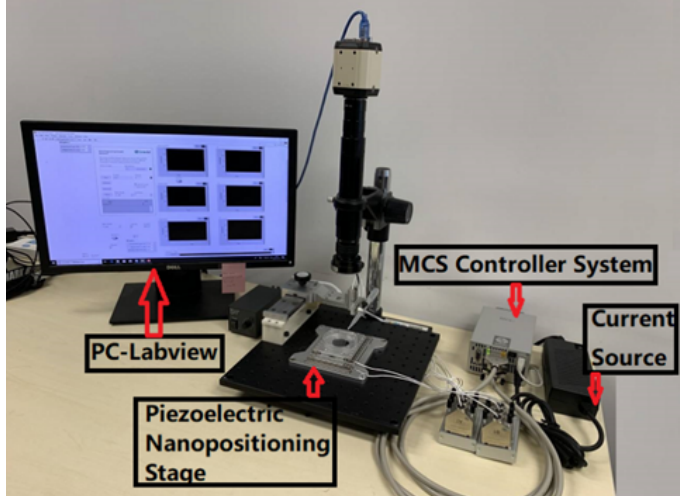
Figure 2. Experimental setup of piezoelectric nanopositioning stage system.